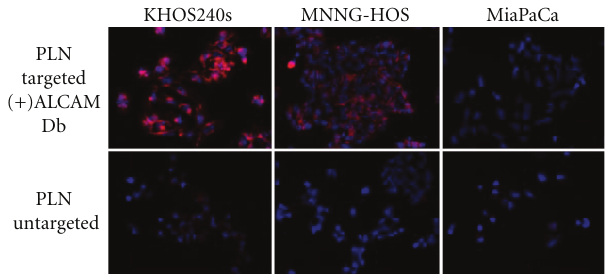
Figure 4: α -ALCAM-targeted PLNs bind specifically to osteosar- coma cell lines. α -ALCAM cys-diabody conjugated PLNs show specific binding (red) to two osteosarcoma cell lines expressing ALCAM, KHOS240s and MNNG-HOS. There was no binding to a cell line that does not express ALCAM, MiaPaCa. Fluorescence microscopy of PLNs is shown in red and DAPI nuclear counter- staining in blue (magnification 20x).